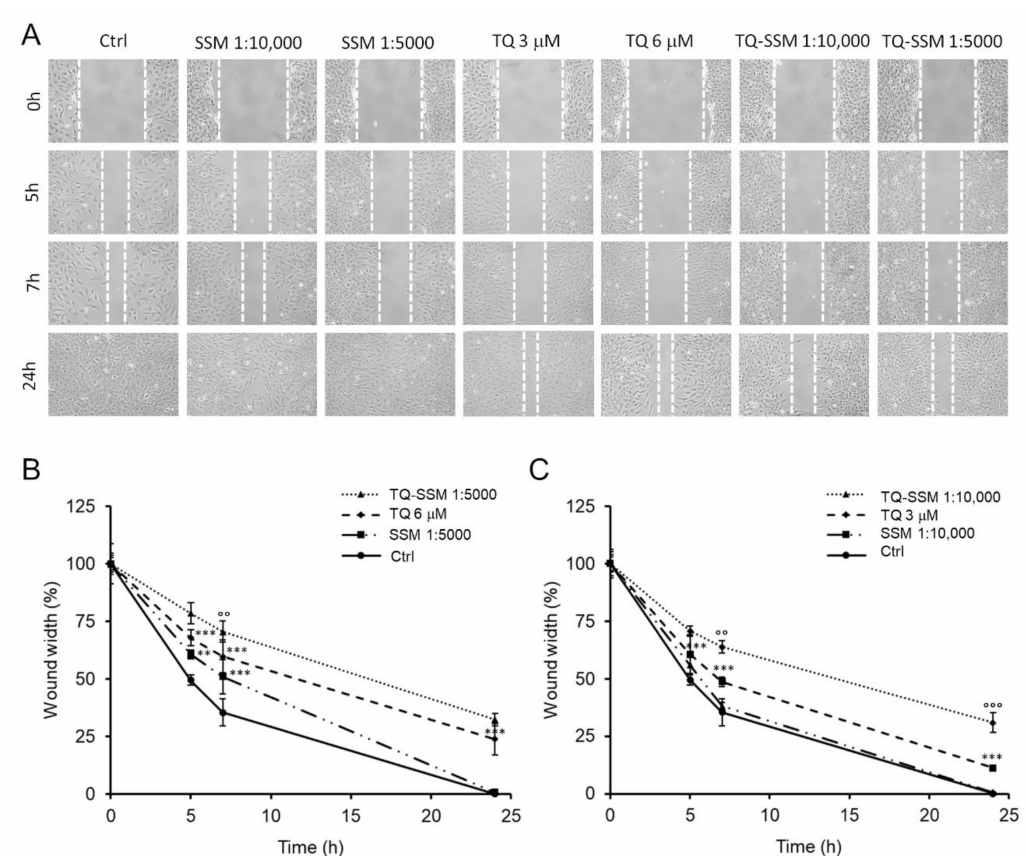
Figure 8. TQ-SSM e ff ect on SH-SY5Y cell migration. ( A ) Representative image of SH-SY5Y cells, untreated or treated with empty SSM, TQ, or TQ-SSM for 24 h under starvation conditions. Scratch closure was monitored over time in cells. The dashed lines mark the edges of the wound area. ( B ) Time course analysis of the scratch closure of SH-SY5Y cells treated with TQ-SSM 1:5000, TQ 6 µ M or SSM 1:5000. ( C ) Time course analysis of the scratch closure of SH-SY5Y cells treated with TQ-SSM 1:10,000, TQ 3 µ M or SSM 1:10,000. Wound width values were reported as a percentage ratio with respect to the 0 h time point. Data are expressed as the mean ± standard deviation of at least three independent experiments. Error bars represent standard deviation. ** p -value < 0.01, *** p -value <